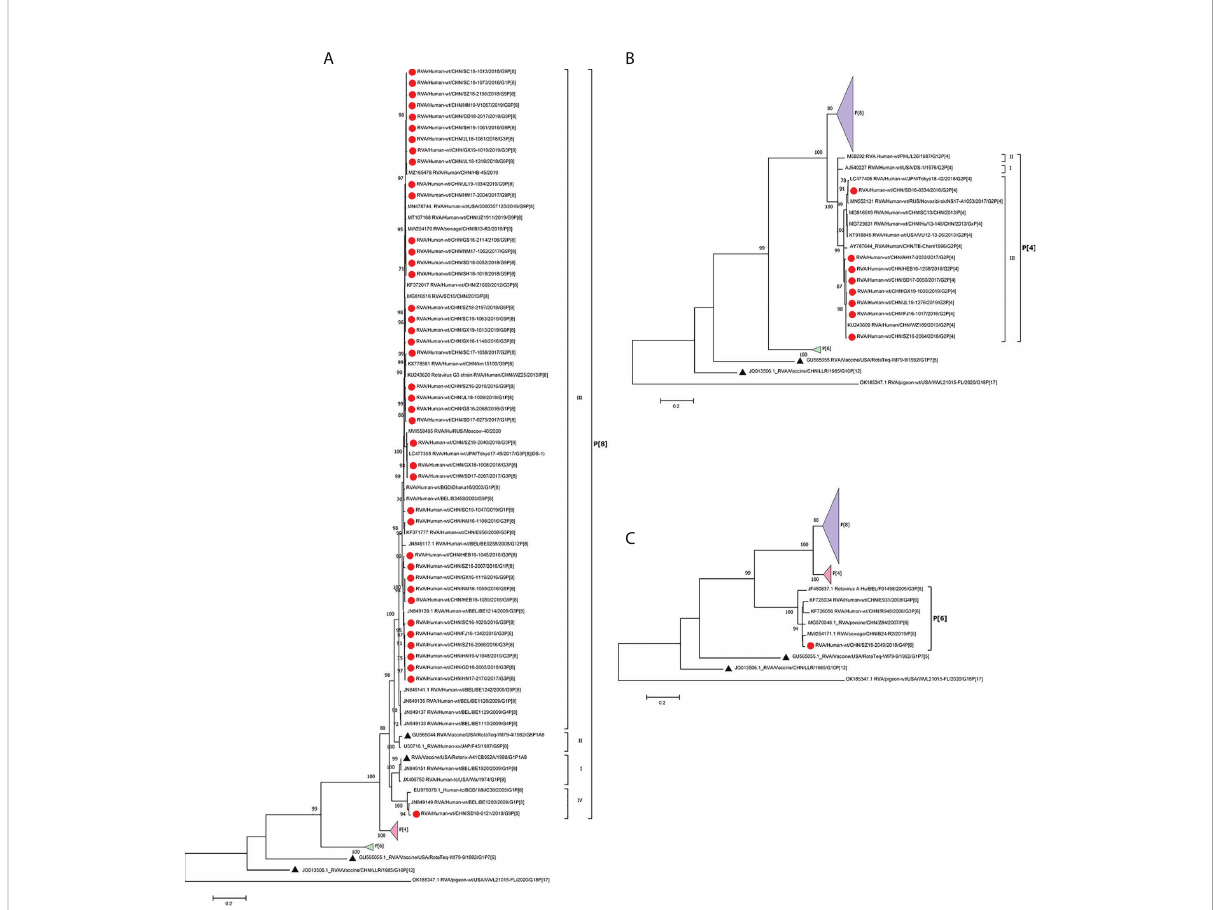
FIGURE 2 Phylogenetic analysis of the VP4 protein of circulating and vaccine RVA strains (RotaTeq P[8], P[5], Rotarix P[8], LLR). Maximum-likelihood trees (A – C) were constructed based on the partial VP7 CDS region sequences (2088 base pairs). A GTR+G+I nucleotide substitution model was used to construct the phylogenetic tree. The pigeon RVA strain WVL21015-FL was used as the outgroup. Chinese strains are marked by red dots and vaccine strains by black triangles. Bootstrap values (1,000 replicates) of 70% are